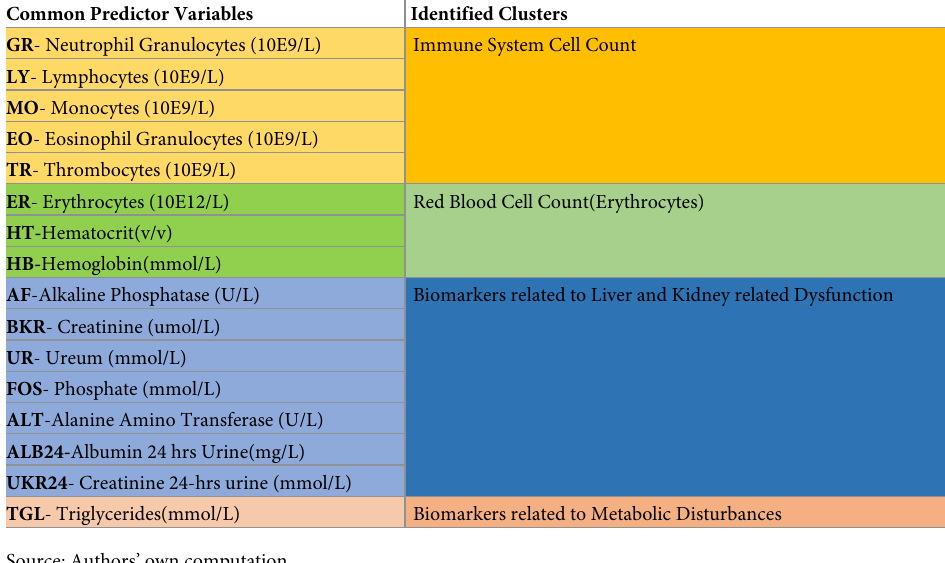
Table 2. Segmentation of common predictor biomarker variables corresponding to anxiety disorder